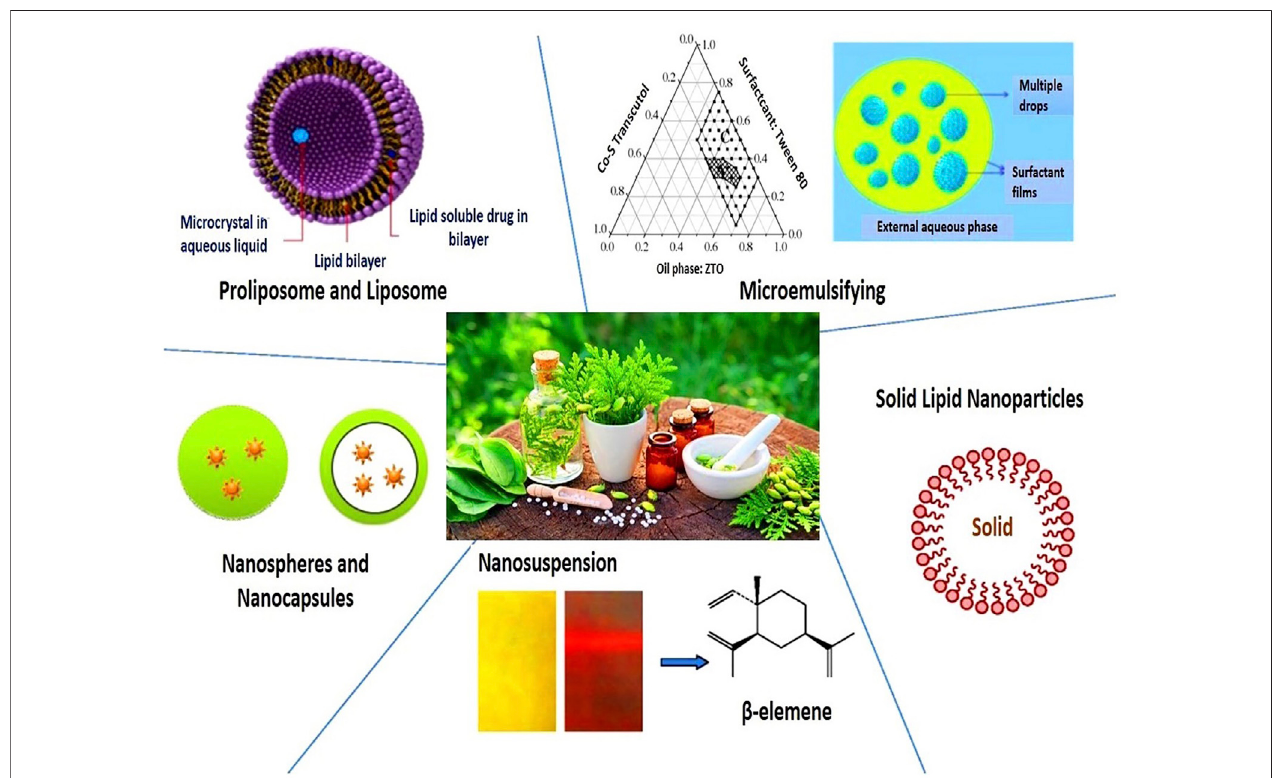
FIGURE 3 | Nanoparticle drug delivery systems for herbal drug formulations (Ahmed et al., 2021).